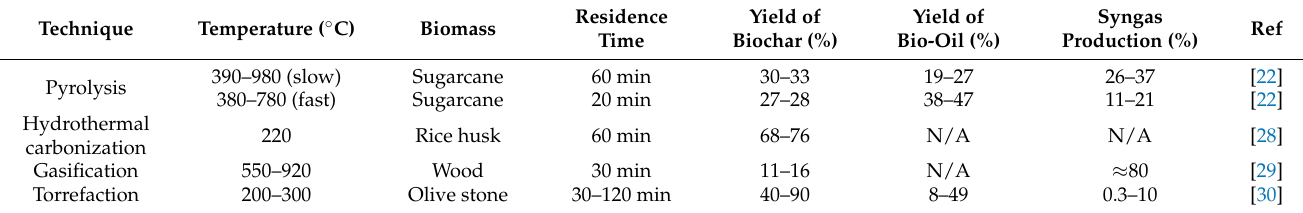
Table 1. Thermochemical conversion